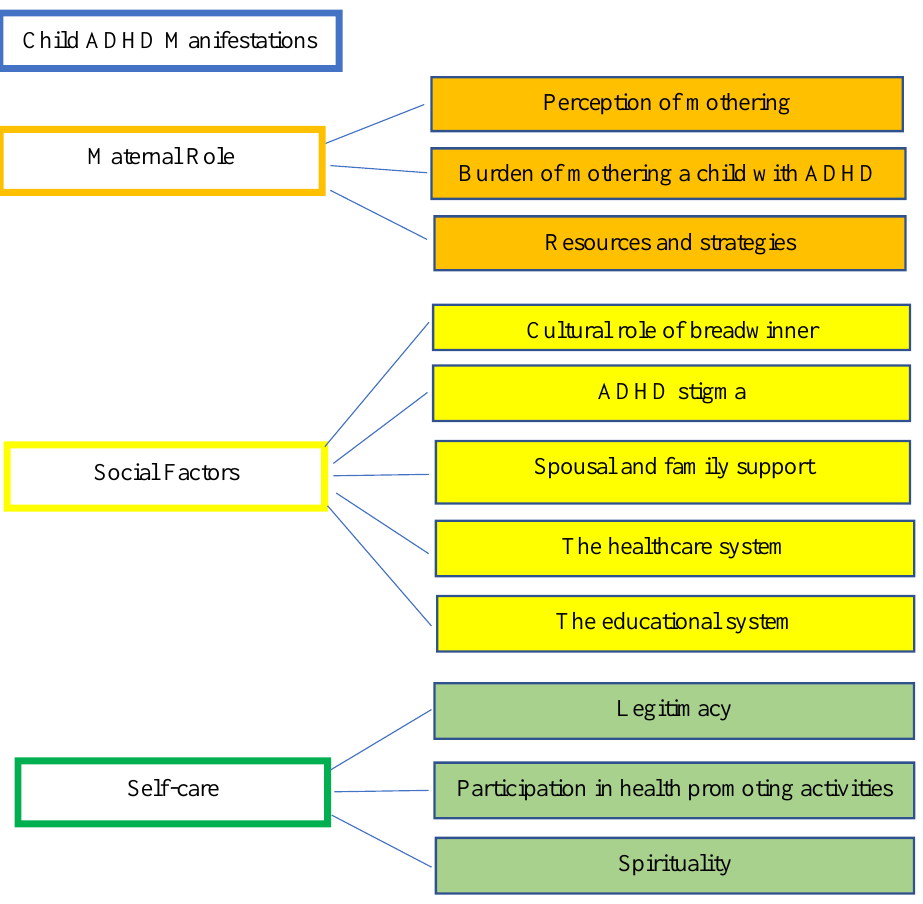
Figure 1. Themes and sub-themes obtained from interviews.